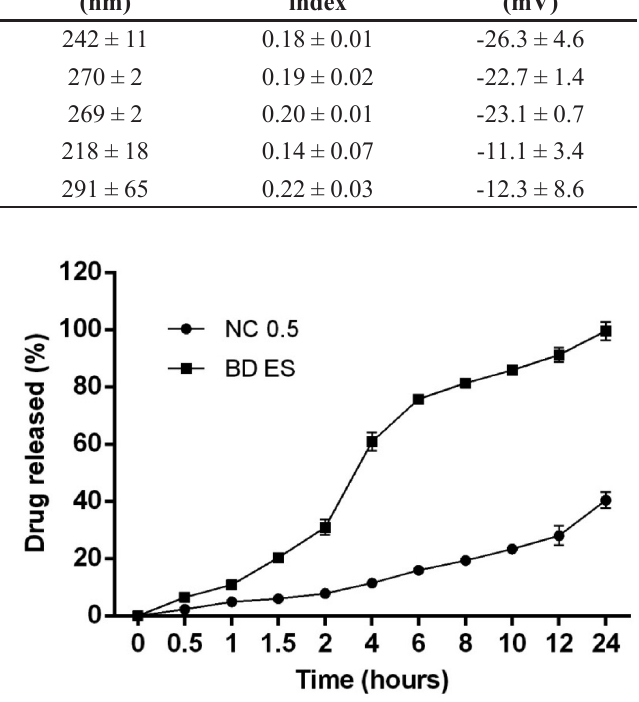
FIGURE 3 - In vitro beclomethasone dipropionate release profiles from nanocapsules (NC-0.5) and ethanolic solution (BD-ES) through the dialysis bag method ( n =3).